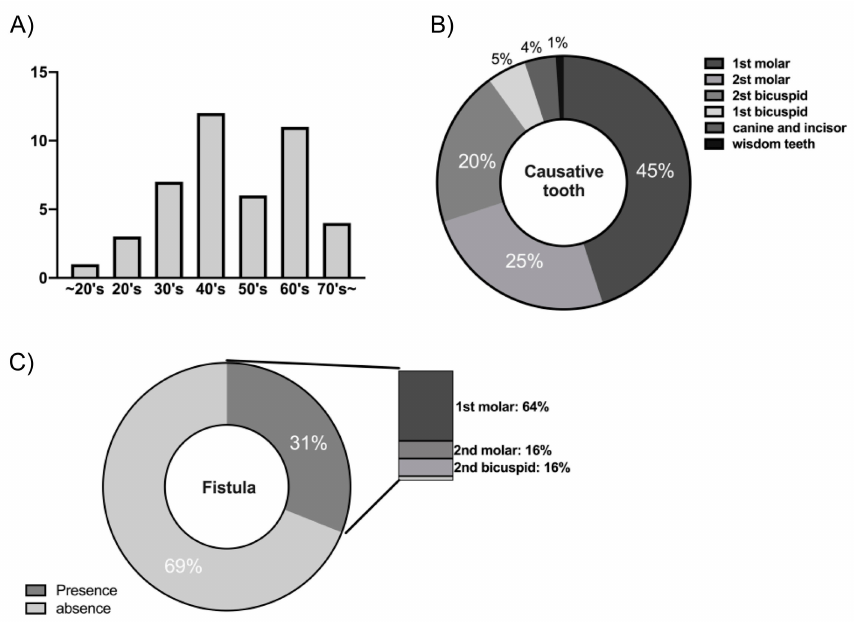
Figure 2. ( A ) Age distribution. Average age is 50.0 ± 15.0 years old, male to female ratio is about 1:1; ( B ) Causative tooth details; ( C ) Presence and location of oroantral fistulae of all root apex lesions. Sinus CT findings showed soft shadows in the maxillary sinus only in 11 cases (25%), while the other 33 cases (75%) had soft shadows in multiple sinuses. The diseased side